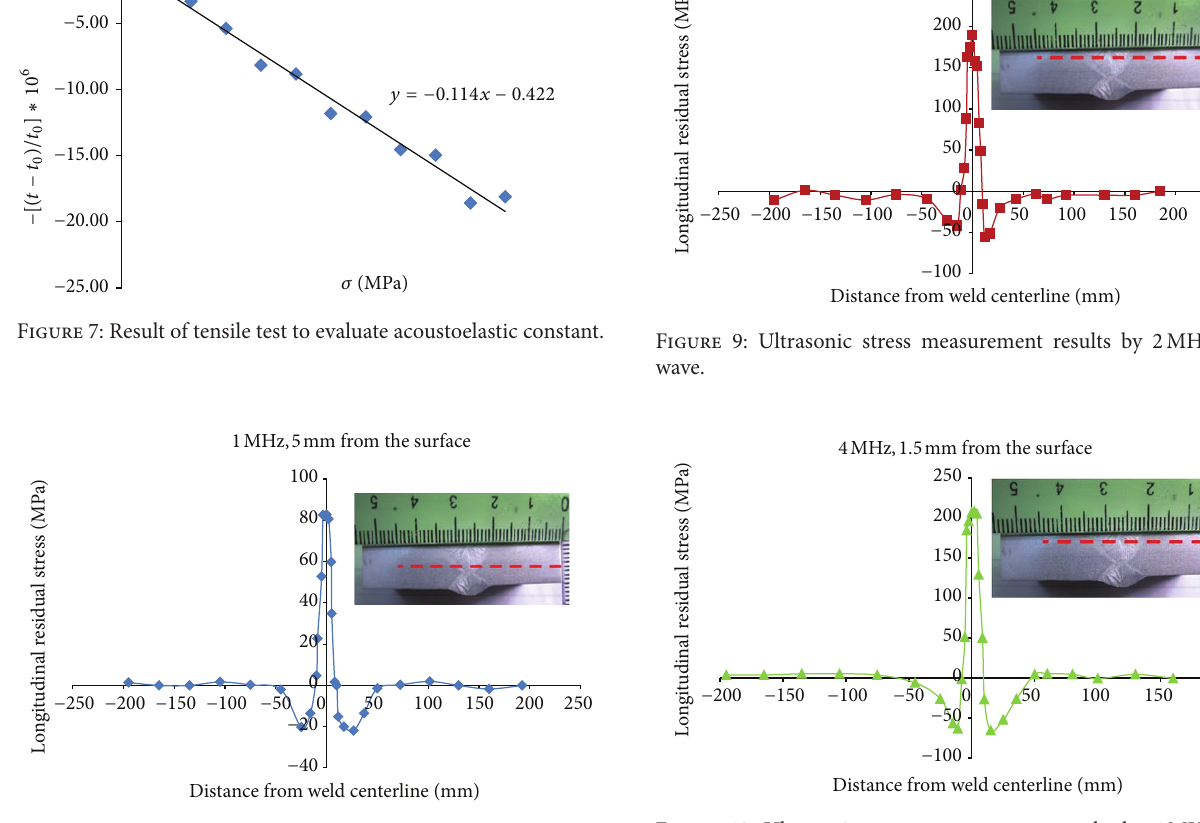
Figure 10: Ultrasonic stress measurement results by 4MHz L CR